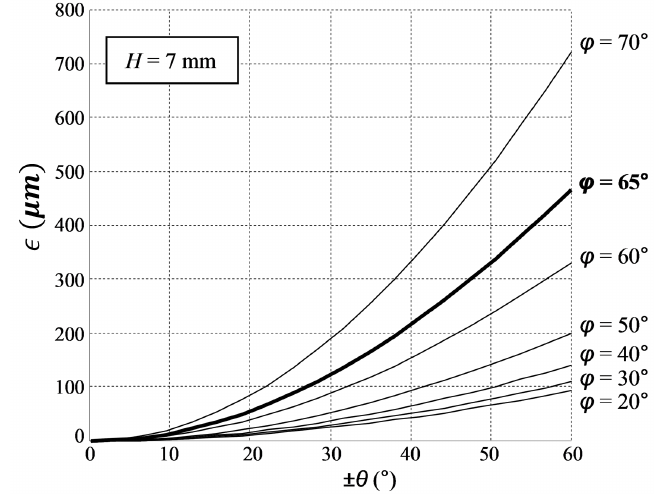
Figure 12. Set of pairs ( ϕ, t ) satisfying the objective K (aluminum material, dimensions H = 7 mm, w = 9 mm).